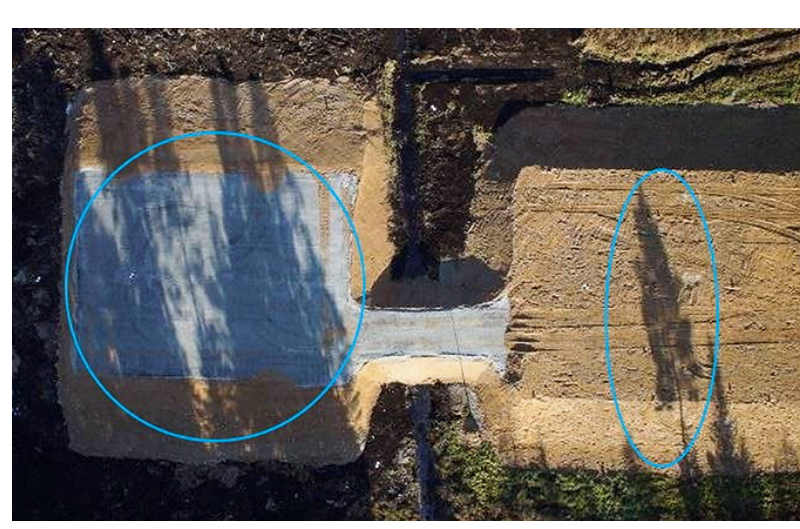
Figure 7. Comparison of the unmanned aerial vehicle surface models